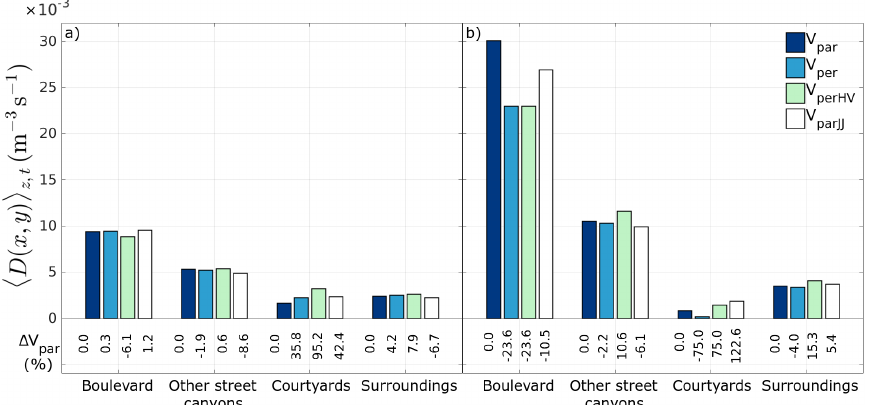
Figure A4. Mean (cid:104) D ( x , y ) (cid:105) t , z ( × 10 − 3 m − 3 s − 1 ) for the ( a ) neutral run with an easterly wind and ( b ) stable run with a southwesterly wind separately for the boulevard, other street canyons, courtyards and surroundings between z = 1–20 m for all runs. D is calculated using data from the first 50 s after the particle source has been switched off. The difference to the value in V par is given in percentages ( ∆ V par